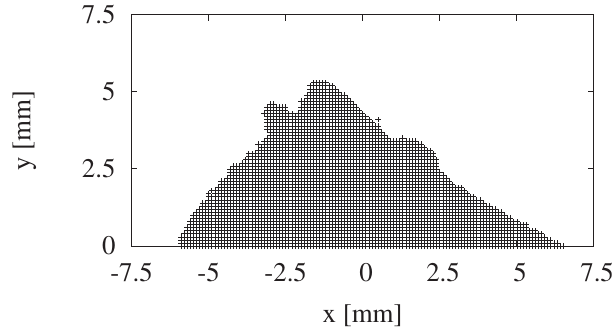
FIG. 6. The configuration of the on-momentum dynamic ap- erture in x - y plane, at the center of the deflector. This aperture has been calculated at the operating point (cid:4) (cid:5) (cid:4) 2 : 072 ; 2 : 072 (cid:5) . The horizontal dynamic aperture is not symmet- ric since the force driving the horizontal betatron motion is not symmetric about x